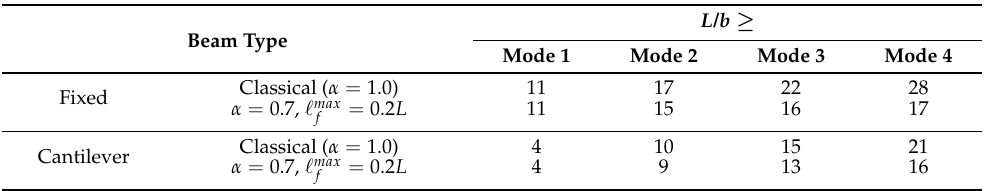
= 0.2 L , contrasted with the results for f = 0.2 L ) f